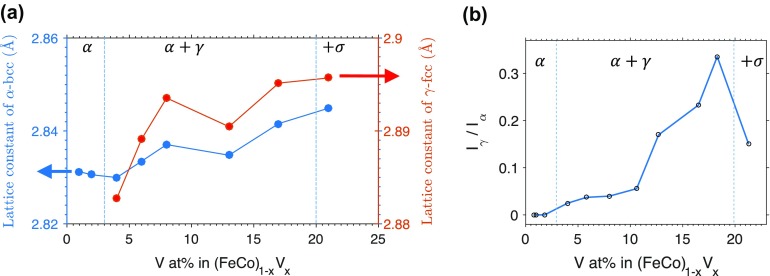
(a) Dependence of lattice parameters on V concentration for α-bcc and γ-fcc phases of Fe-Co-V samples with nominally equal atomic concentrations of Fe and Co. (b) Ratio of the diffraction peak intensities for the γ-fcc (111) peak divided by the α-bcc (110) peak versus V composition. In (a) and (b) vertical dashed lines are boundaries separating various phase regions labeled in Greek letters.